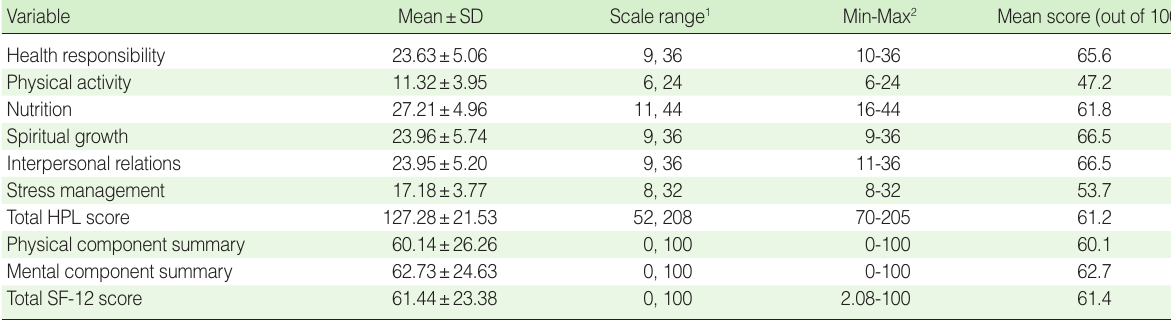
Table 2. Mean scores of the HPL and quality of life